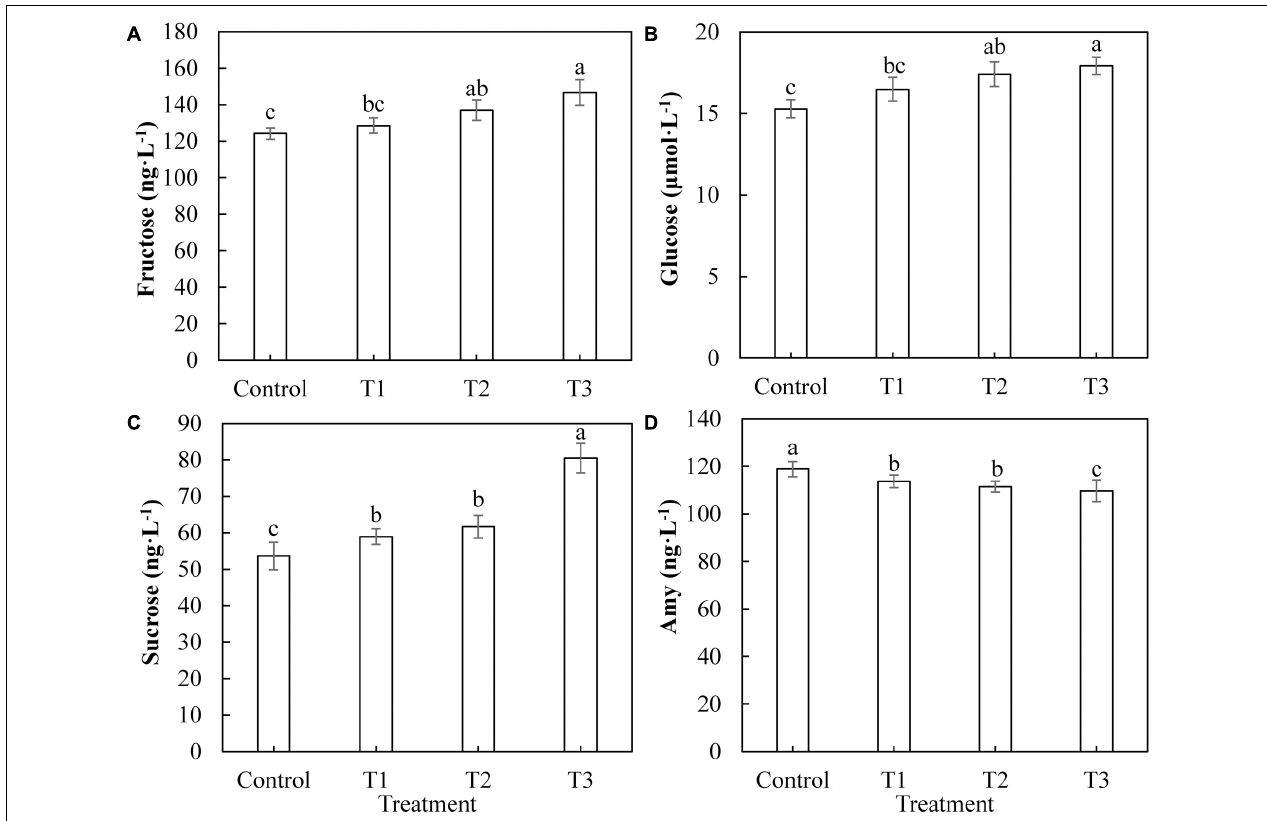
FIGURE 8 | Effects of supplemental LED light duration on the contents of photosynthetic products: fructose (A) , glucose (B) , sucrose (C) , and starch (D) in cucumber leaves. After LED light supplement treatment for 30 days, 10 pieces of the third leaf from the top of cucumber were selected from each treatment, washed and dried immediately, and then put into liquid nitrogen for the determination of photosynthate contents. Values are expressed as mean ± SE ( n = 3). Bars that are significantly different based on the Duncan’s multiple range test ( p < 0.05) are indicated with different lowercase